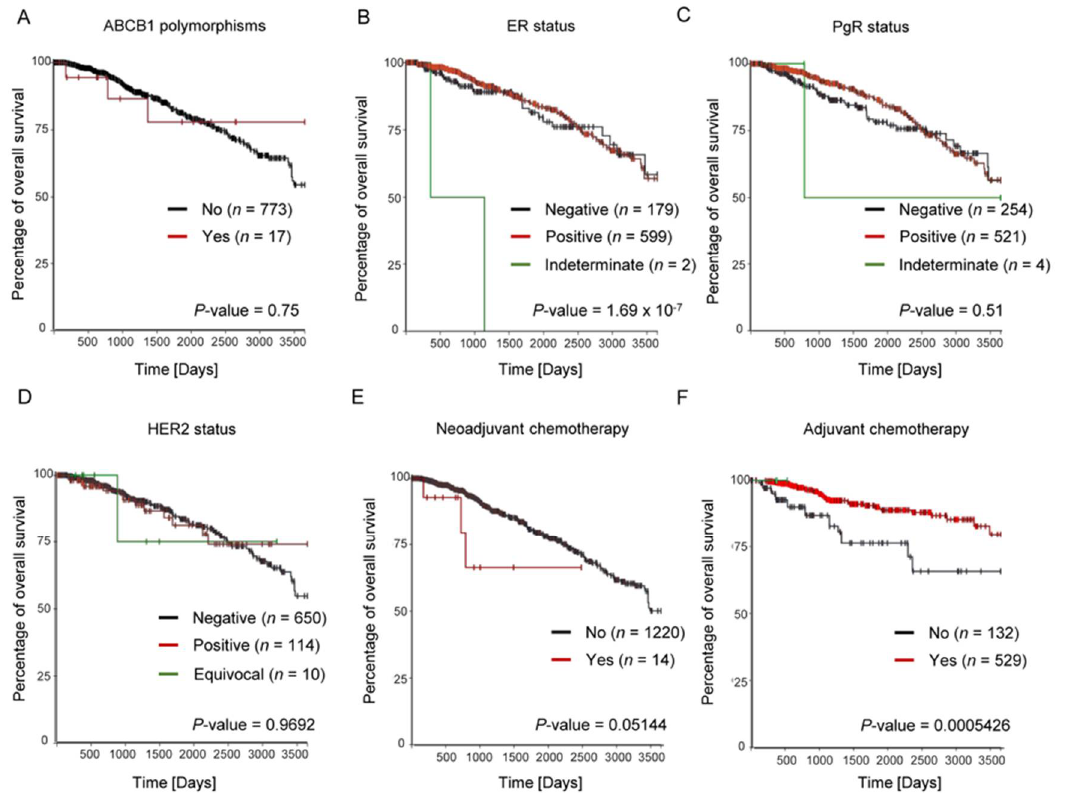
Figure 2. Overall survival analysis in reference to the TCGA breast cancer database. ( A ) Kaplan–Meier curves of overall survival of patients with breast cancer for ABCB1 polymorphisms. For each analysis, patients were divided into two groups: with a presence (red line) or absence of polymorphisms (black line); Kaplan–Meier curves of overall survival of patients with breast cancer with ER ( B ), PgR ( C ), and HER2 ( D ) receptor status was analyzed; red line—positive, black line—negative. The impact of neoadjuvant chemotherapy treatment (( E ) black line—treated patients; red line—non-treated patients) and adjuvant chemotherapy (( F ) black line—treated patients; red line—non-treated patients) on overall survival was also assessed. All Kaplan–Meier survival curves were generated using the Xena browser.